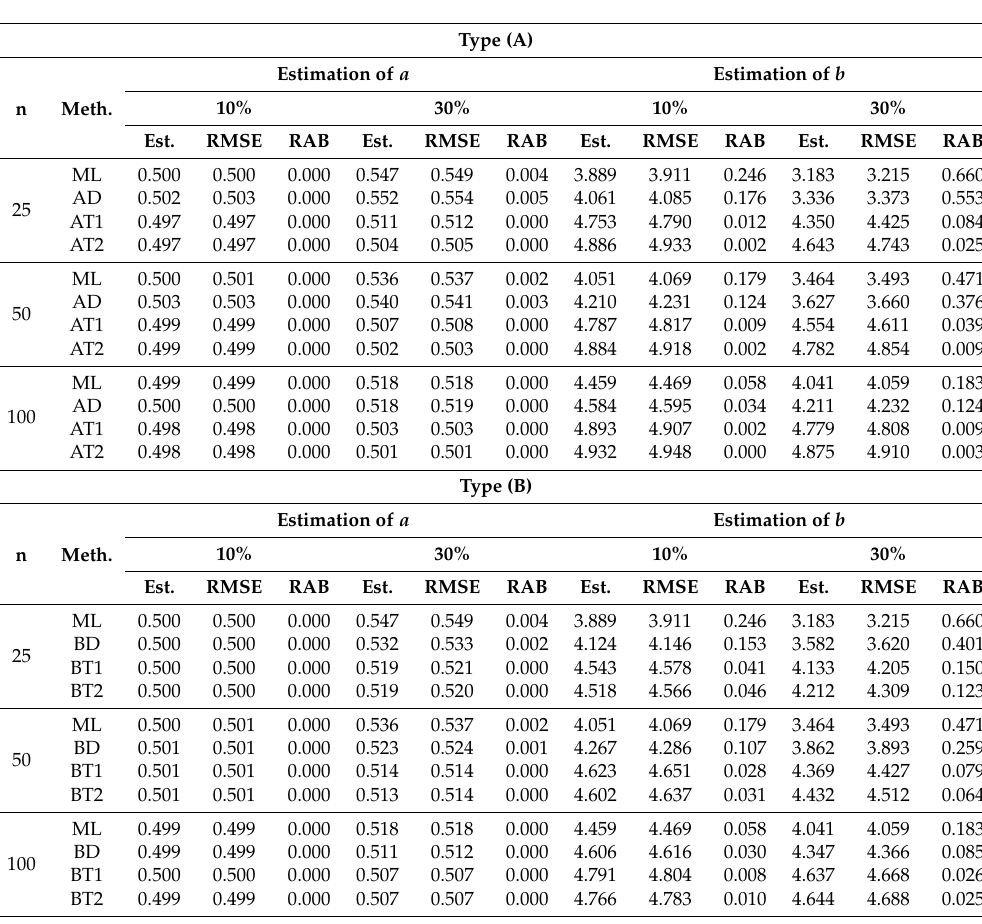
Table 4. The estimates, root of mean square error (RMSE) and relative absolute biases (RABs) for two parameters of the Weibull distribution using TL-moments, direct L-moments, and ML method based on right censoring ( a = 0.5 and b = 5) in the presence of